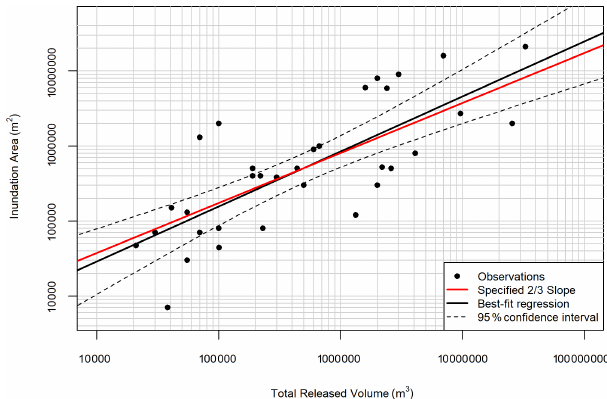
Figure 6. Log-log scatter plot of planimetric Zone 1 inundation area versus total released volume for 33 tailings-flow cases (Table 3). The specified two-thirds slope regression line (in red) is fitted to the data. The best-fit regression line (in black) and the 95% confi- dence intervals (dashed lines) of the best-fit regression are plotted for comparison.